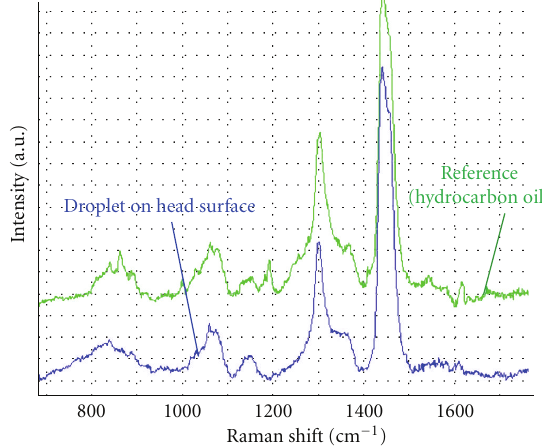
Figure 9: Droplet analysis by Raman spectroscopy.